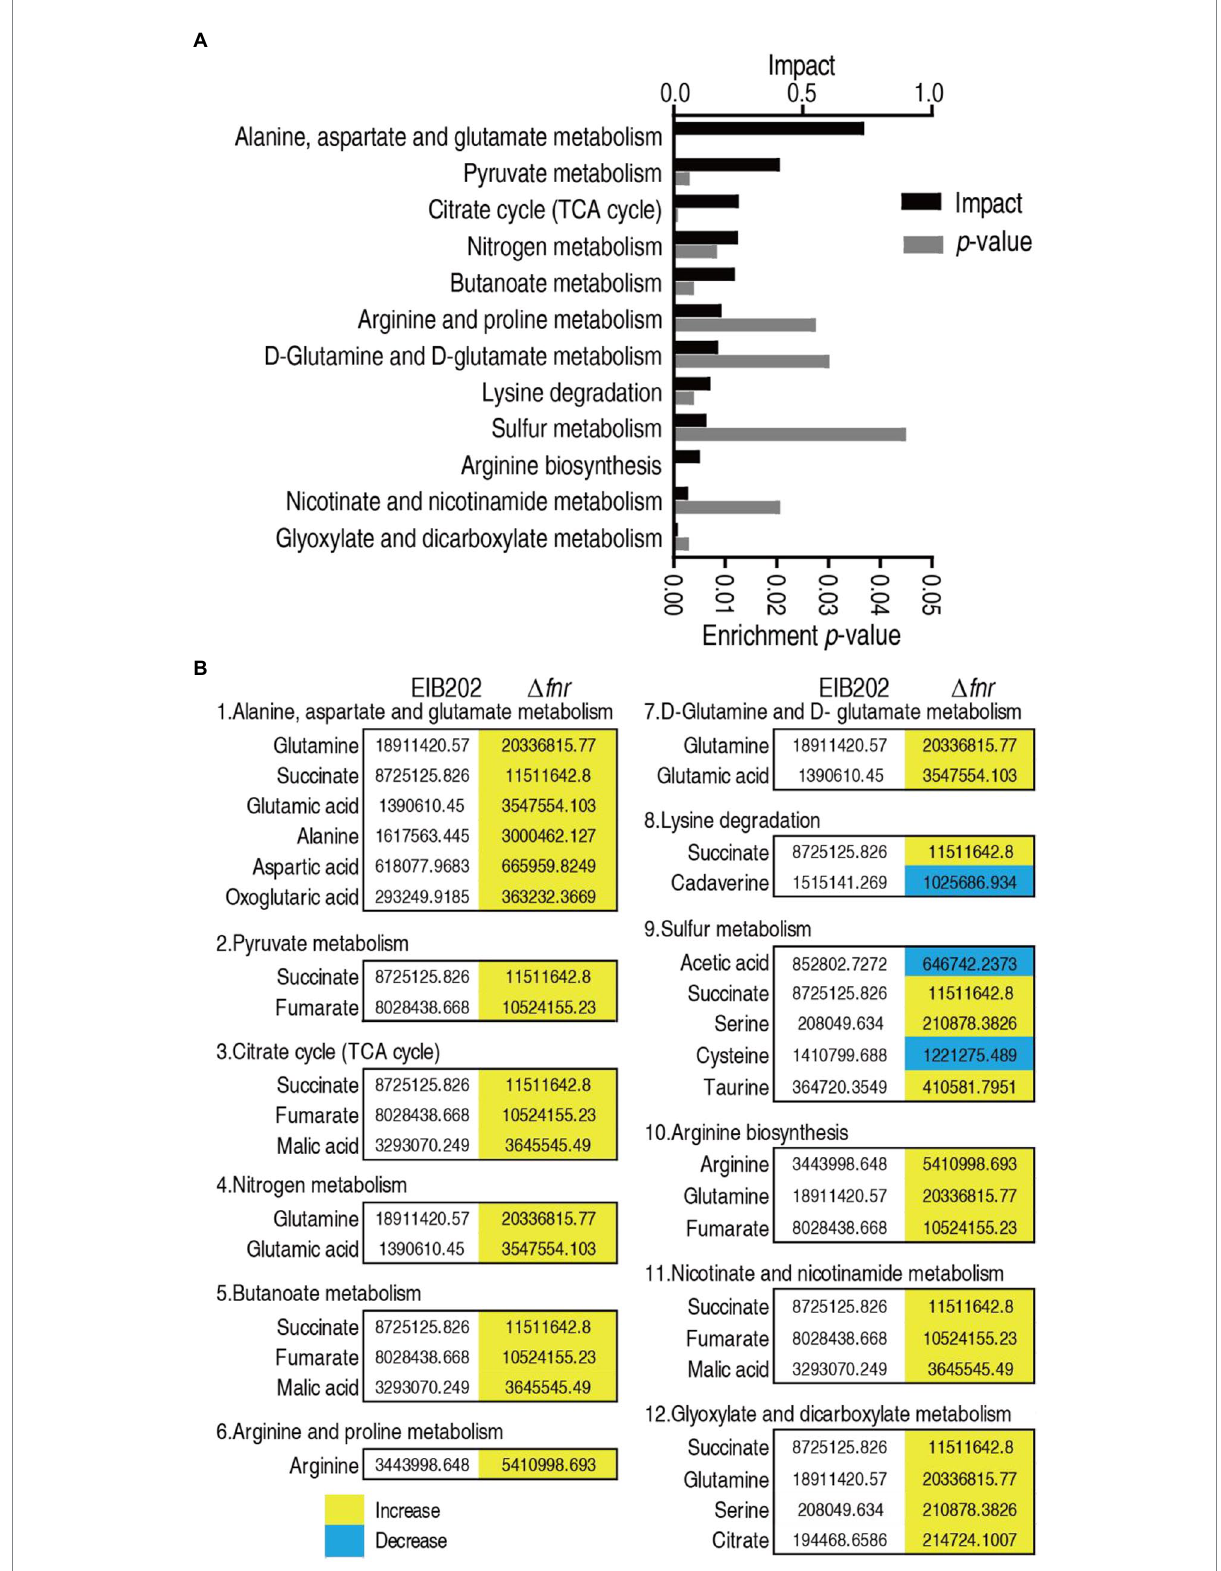
FIGURE 3 Pathway enrichment. (A) Pathway enrichment of varied metabolites in Δ fnr . (B) Integrative analysis of metabolites in significantly enriched pathways. Yellow color and green color indicate increased and decreased metabolites,